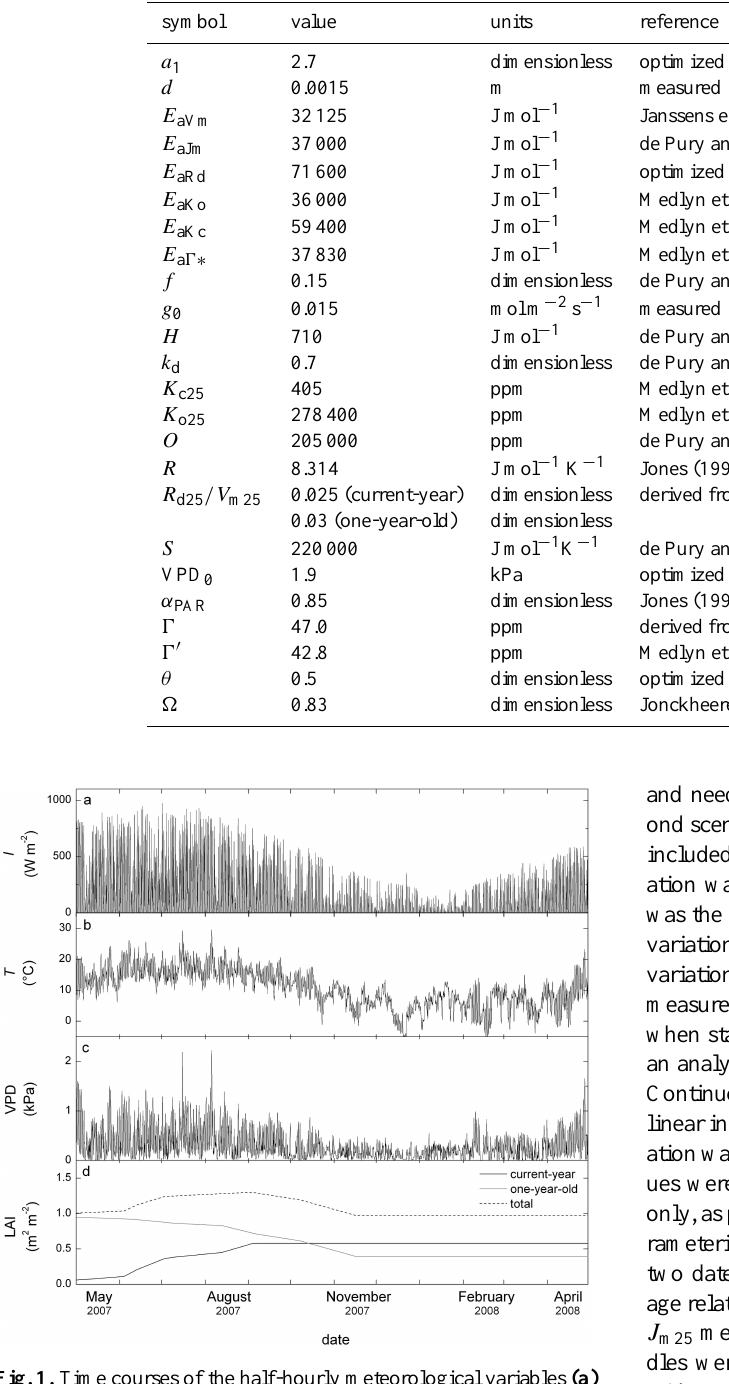
Table 2. List of input parameter constants, with their reference.